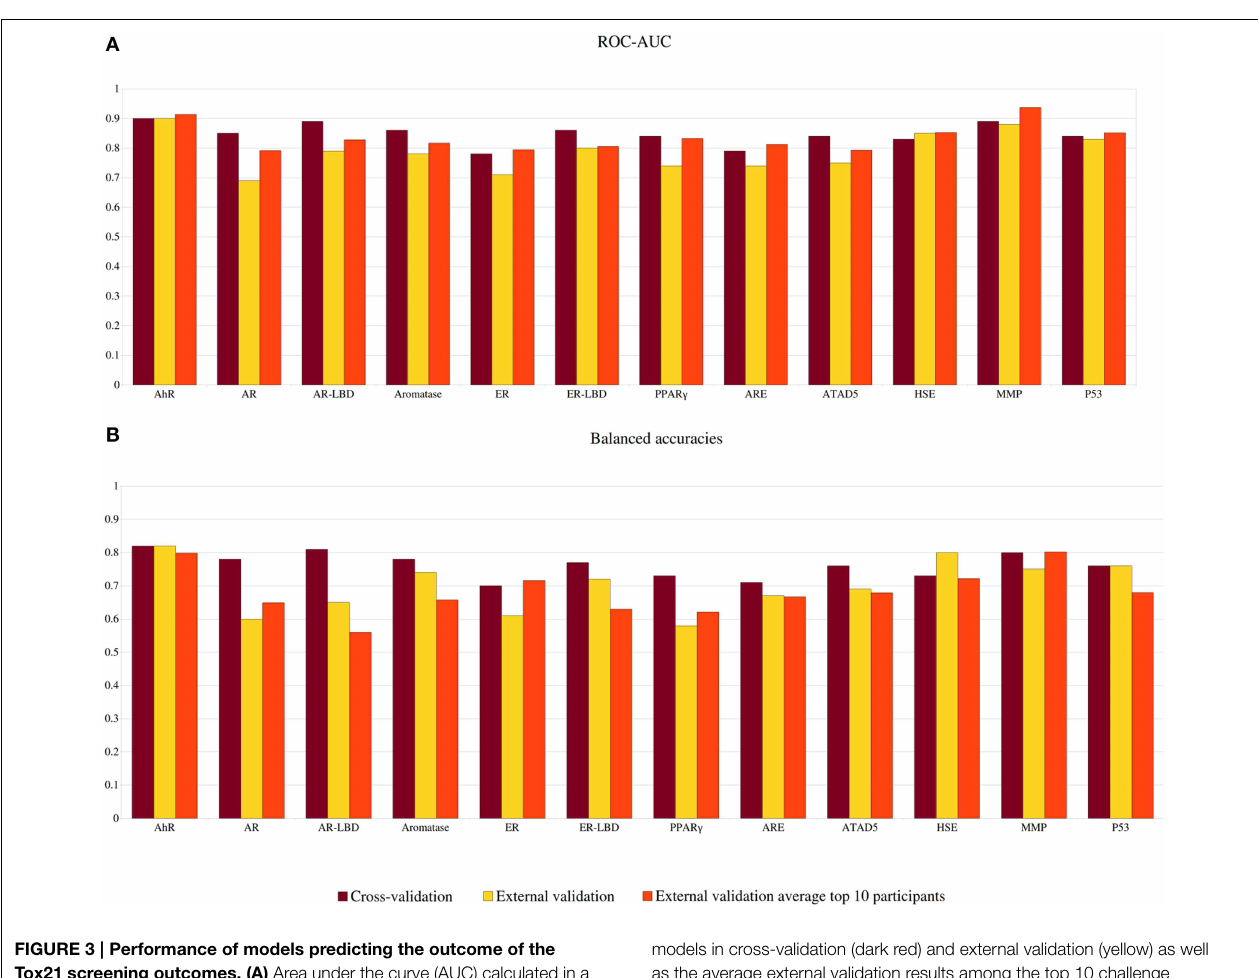
FIGURE 3 | Performance of models predicting the outcome of the Tox21 screening outcomes. (A) Area under the curve (AUC) calculated in a ROC analysis. (B) Balanced accuracies (BAC). Results are shown for our